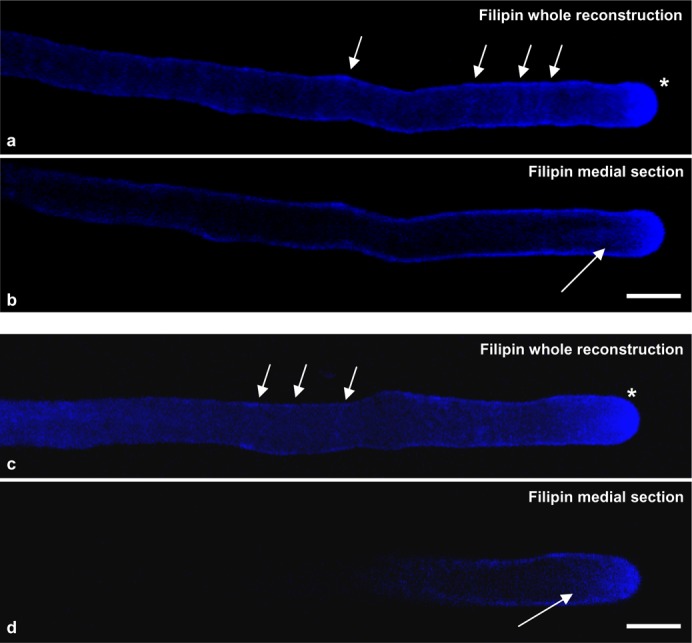
Sterol localisation.(a,c) Whole reconstructions. Sterols are present on the PM, where a ring-like distribution was often evident (arrows). Sterol-rich domains were especially concentrated in the apex PM (asterisks). (b,d) Medial sections. Sterols also accumulate in clear zone vesicles (arrows). Scale bars: 10 µm.